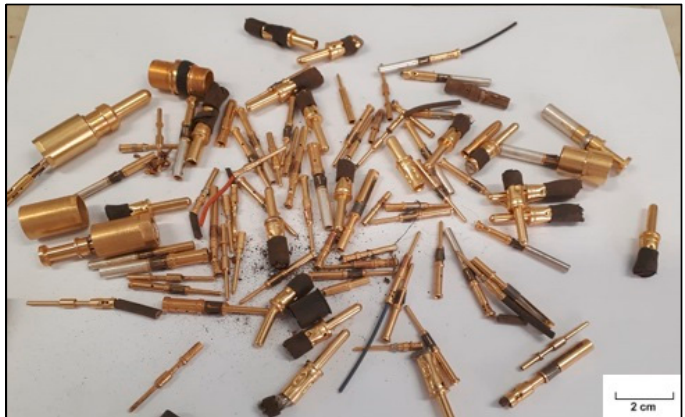
Figure 2. Second sample of connectors.